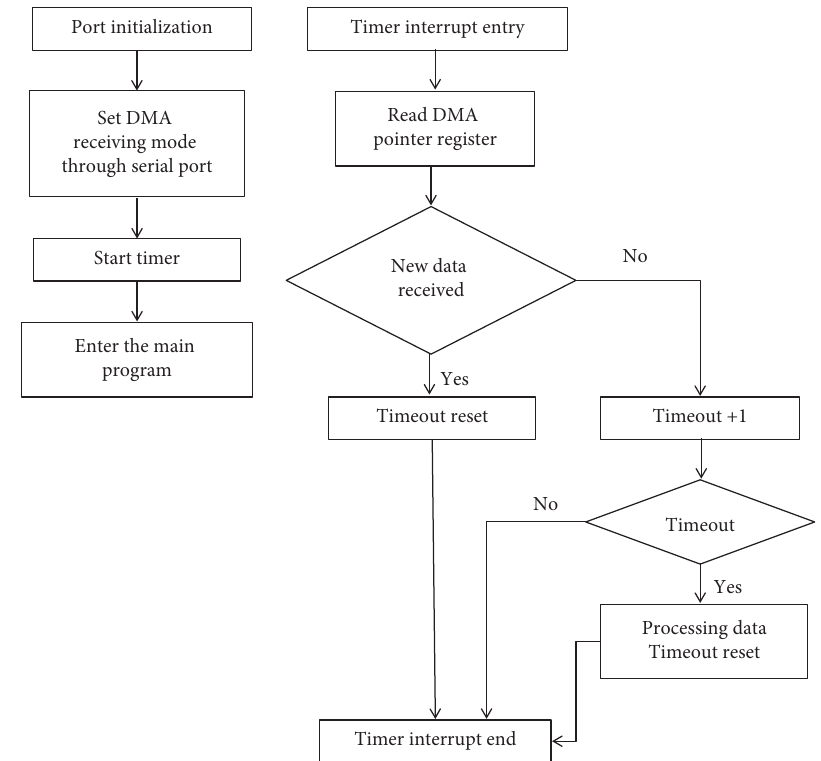
Figure 6: Flow of timeout reception method. Table 2: Data sending format from the probe to the ground